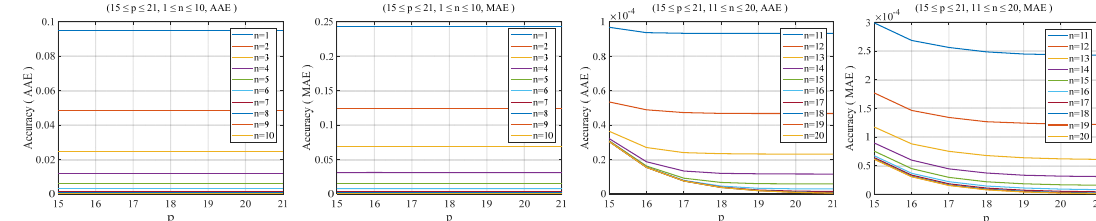
Figure 8. Sigmoid : Accuracy distribution corresponding to Case 3.